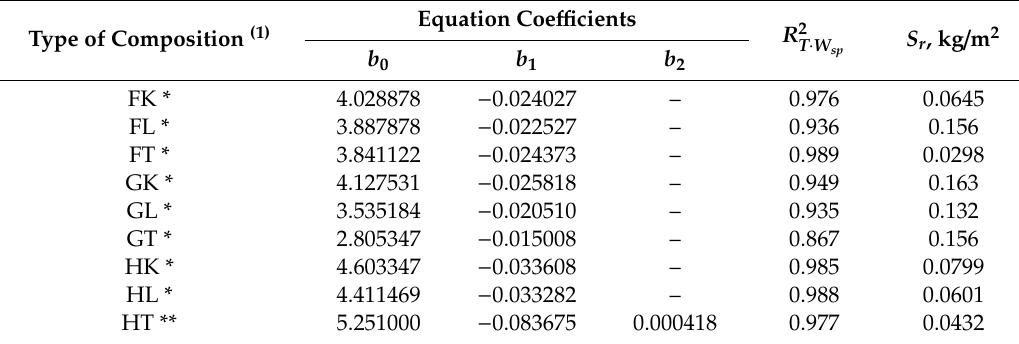
Table 4. Statistical data of short-term water absorption by partial immersion results.